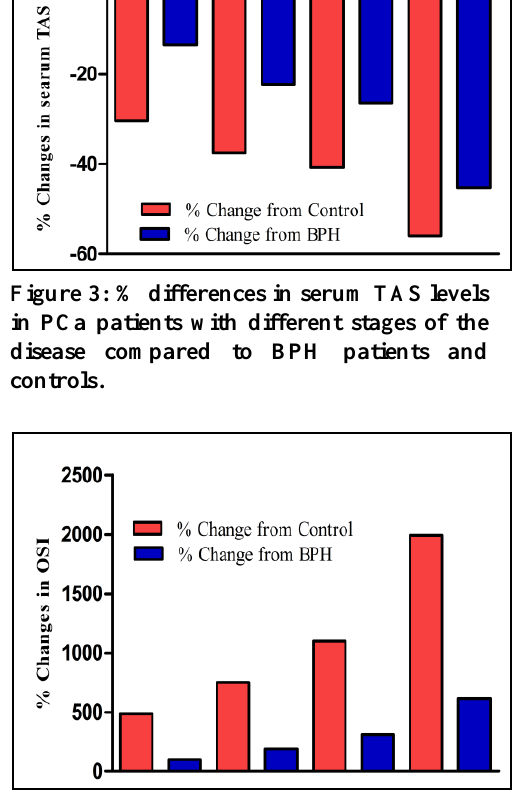
Figure 4: % differences in OSI value in PCa patients with different stages of the disease compared to BPH patients and